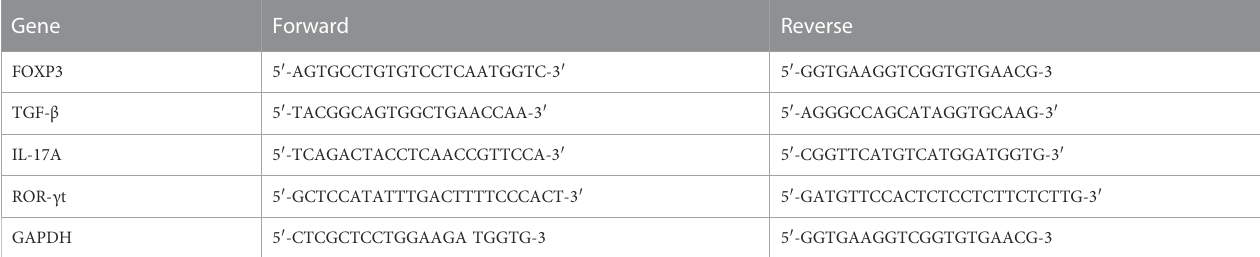
TABLE 1 Speci fi c primers for control and target genes. Gene